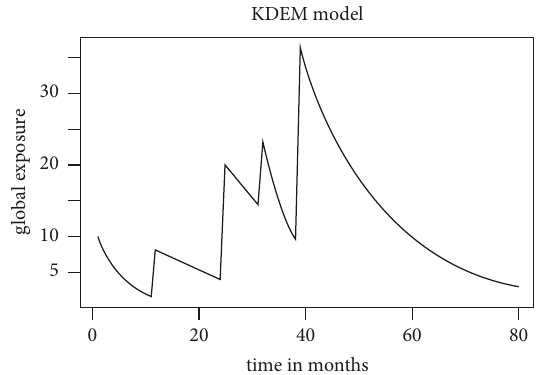
Figure 1: A trajectory of the exposure process to a contaminant through time θ � 0.006418.